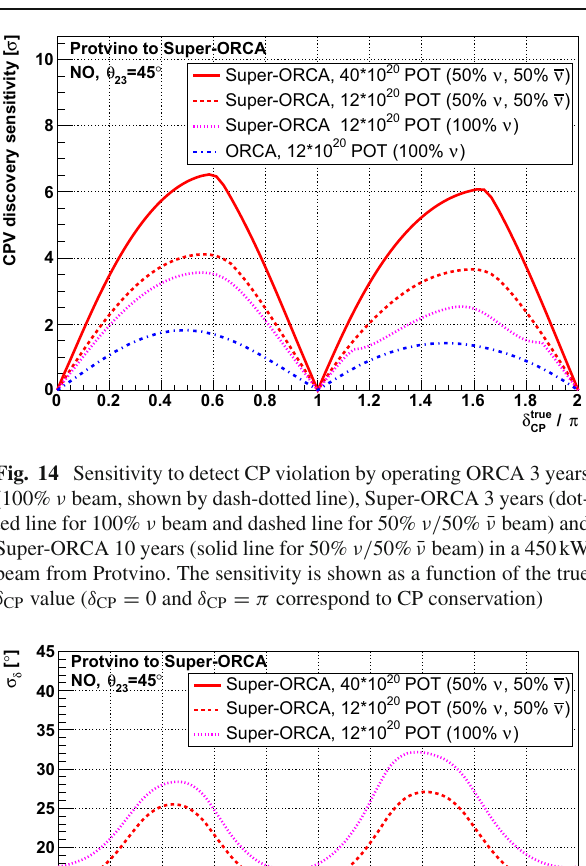
0 Fig. 15 Resolution on δ CP as function of the true δ CP value for Super- ORCA with the 450kW beam operating for 3 years with 100% ν beam (dotted line) and 50% ν/ 50% ¯ ν beam (dashed line) and 10 years with 50% ν/ 50% ¯ ν beam (solid